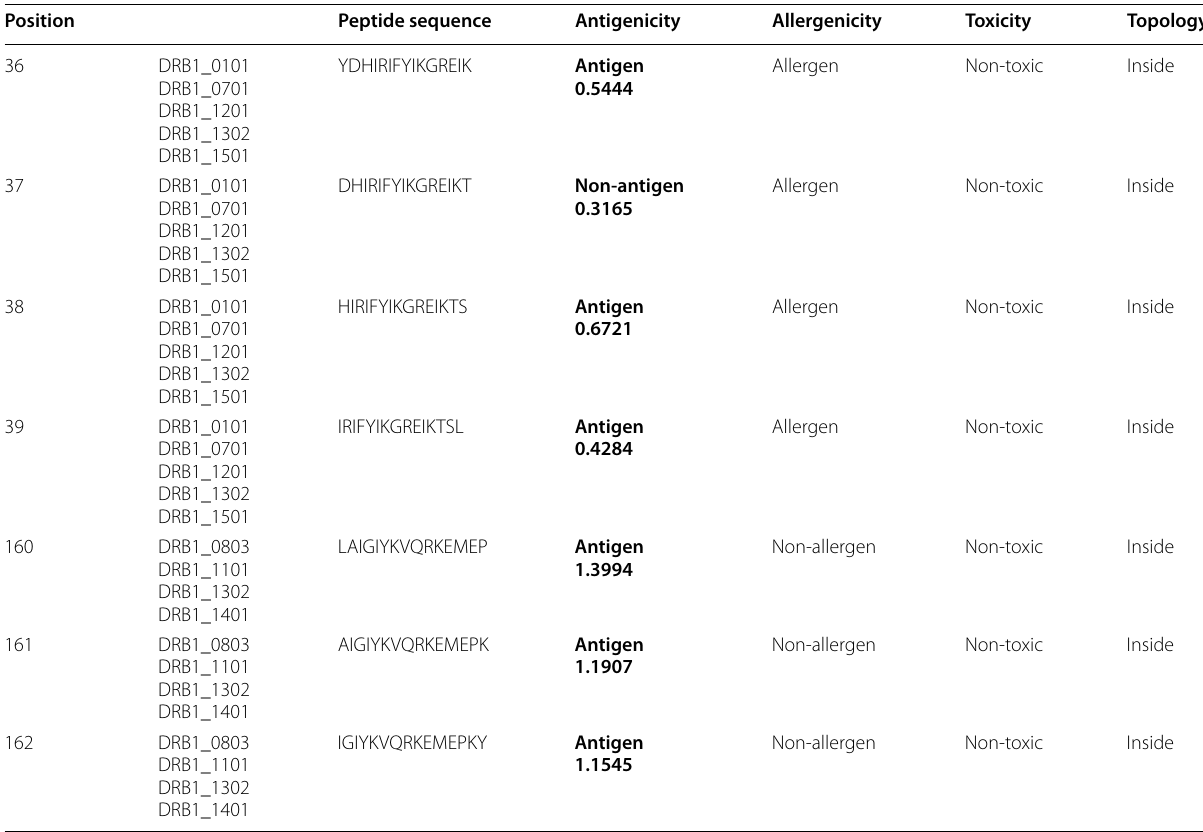
Table 4 MHC Class-II epitope antigenicity, allergenicity, toxicity, and topology parameters Position Peptide sequence